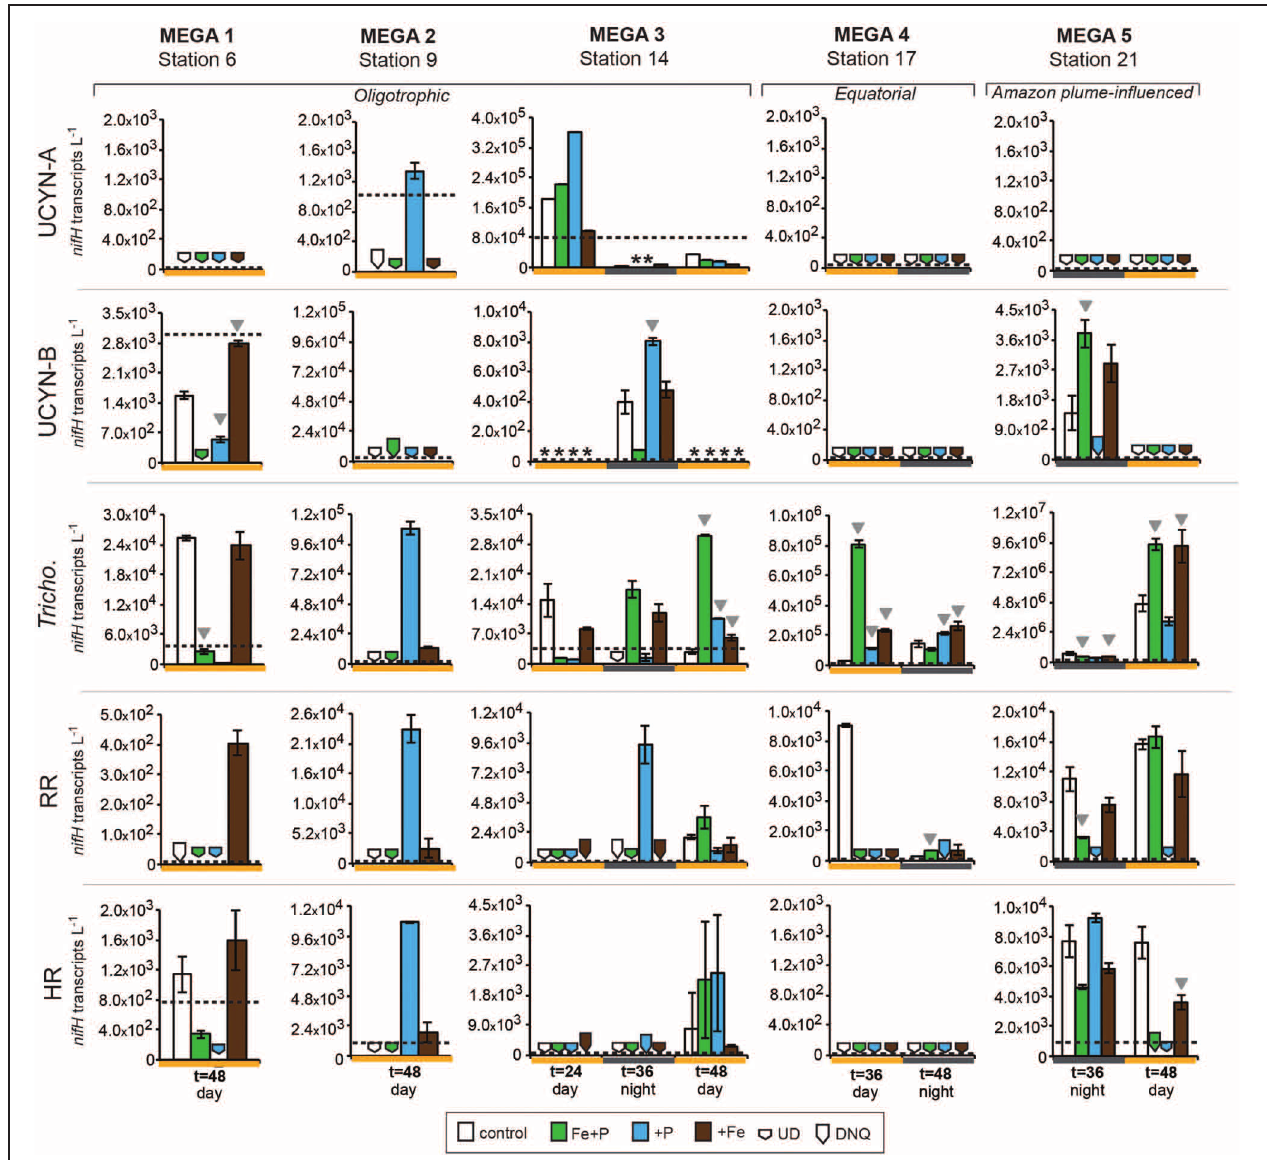
FIGURE 4 | Expression of nifH in response to nutrient additions in the MEGA experiments. Quantified nifH transcripts L − 1 in time zero samples in each experiment for each phylotype is marked with a dotted line. UCYN-A and UCYN-B nifH transcripts L − 1 were quantified from 0.2 µ m filters; Tricho , RR, and HR nifH transcripts L − 1 were quantified from 10 µ m filters. Error